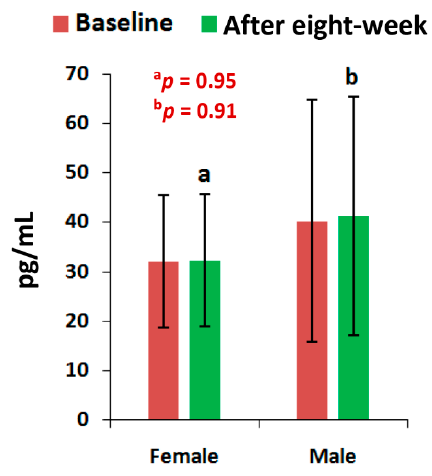
Figure 6. Levels of parathyroid hormone of 45 control subjects, female ( n = 27) and male ( n = 18), before and after eight ‐ week without using supplement ( ᵃ p = 0.95, ᵇ p = 0.91).